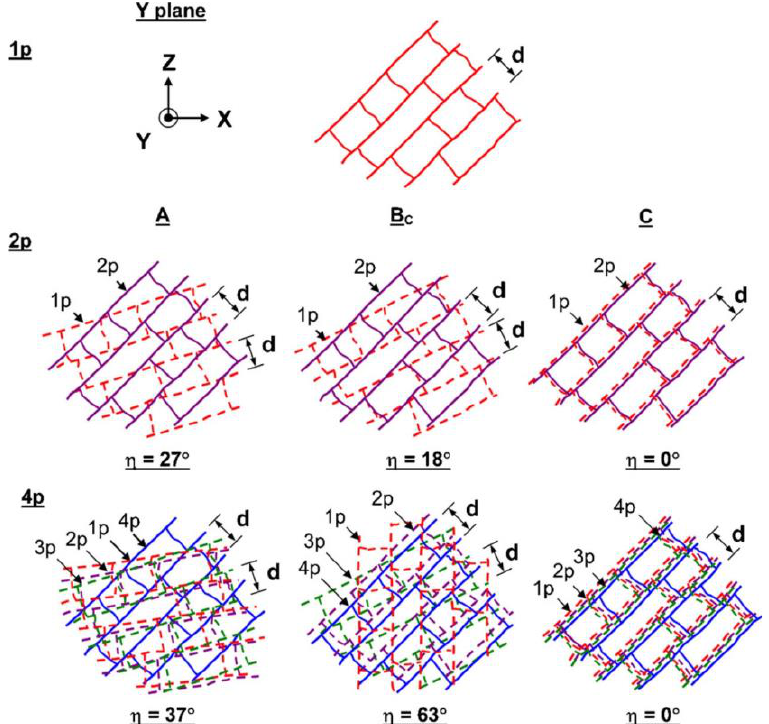
Figure 20. Effect of ECAP route (A, B C , or C) on the grain refinement, where subgrain bands with a width of d are formed along the primary shear during the first (1p), the second (2p), and the fourth (4p) passes Reproduced from [91] with permission from Elsevier, 2023.